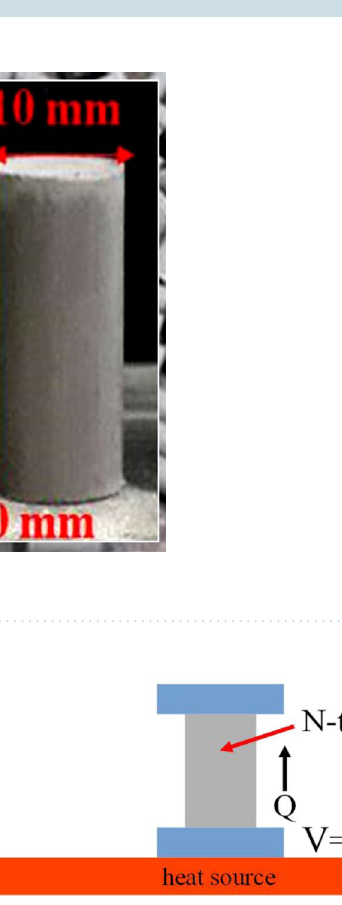
Figure 3. ( a ) The unileg n-type CaMnO 3 TEG module and (b) schematic diagram of the unileg n-type CaMnO 3 TEG module heated by a heat source (hot